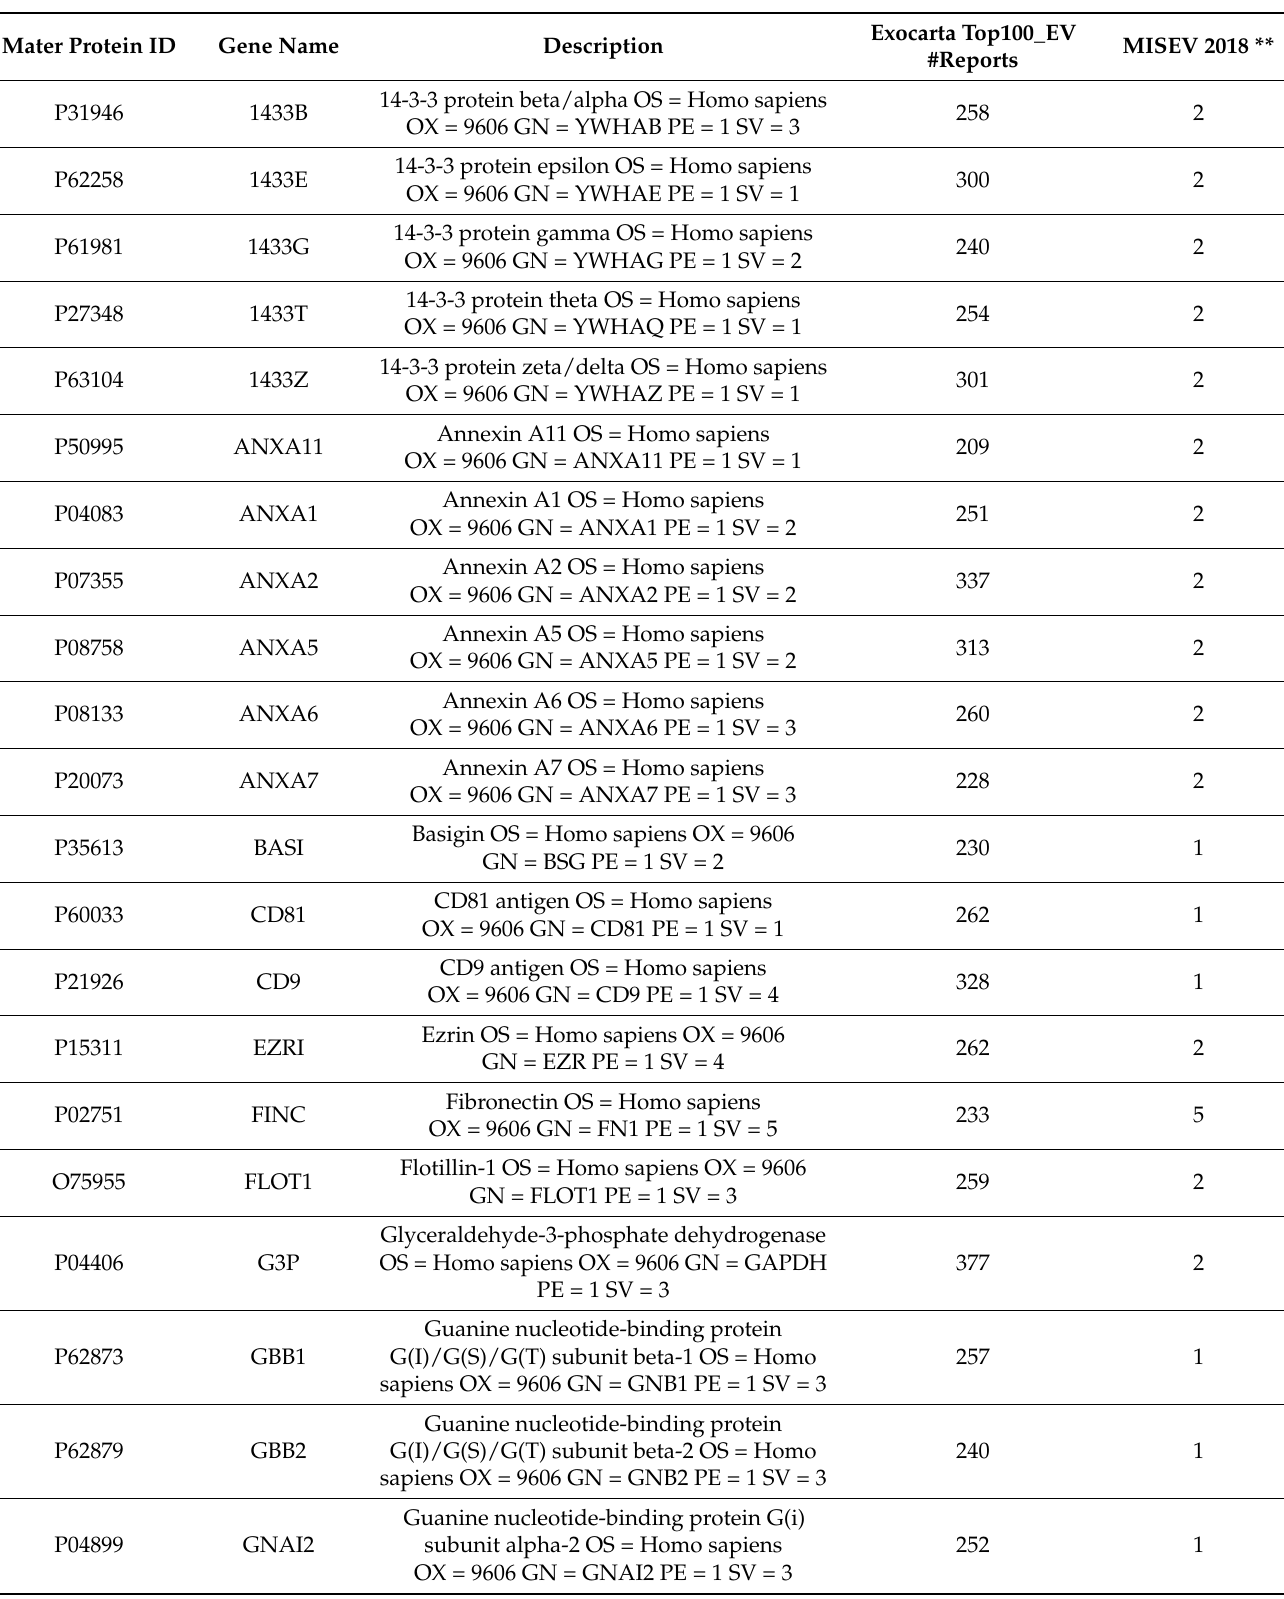
Table 2. Typical sEV markers identified in all our samples by MS